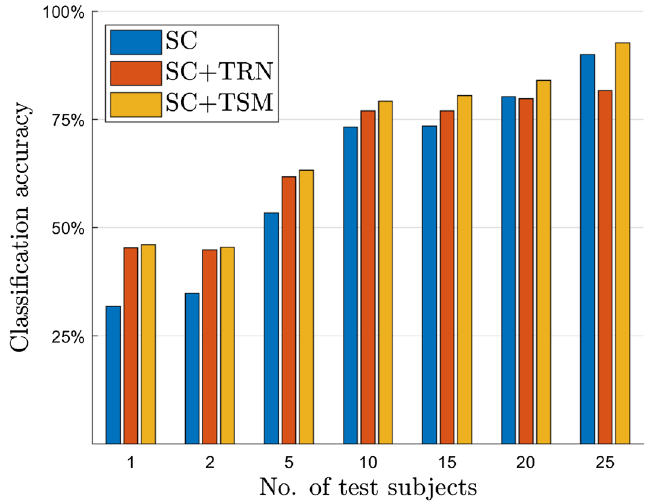
Figure 3. Subjects consensus (SC) as privileged information: EEG boosts video classification. Blue bars correspond to the performance of a DE+MLP (see “Methods” section) model trained on EEG data only: the final classification is done by averaging the softmax prediction over a different number of subjects. Red and yellow bars report the performance of a subject consensus approach on top of the video processing models, in which the averaged prediction over EEG data are furthermore averaged with the prediction of the TRN 22 and TSM 23 architectures, respectively, trained on video data. The selected test videos were not used during training, being therefore never seen before from any of the subject-specific predictions that are averaged. Best viewed in